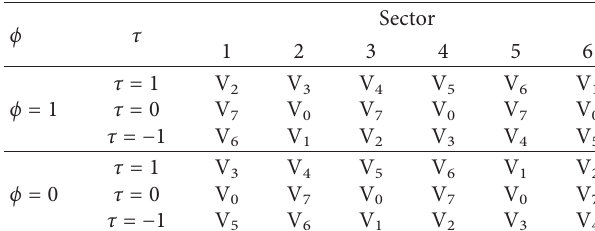
Figure 2: Hysteresis controllers for (a) magnetic flux and (b) electromagnetic torque. Table 1: List of all optimal vectors for the VSI based on the sector number (1–6), the torque error ( τ ), and the flux error ( ϕ